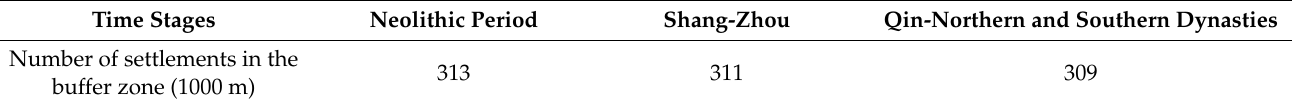
Table 5. Number of settlements distributed in the buffer zone in different